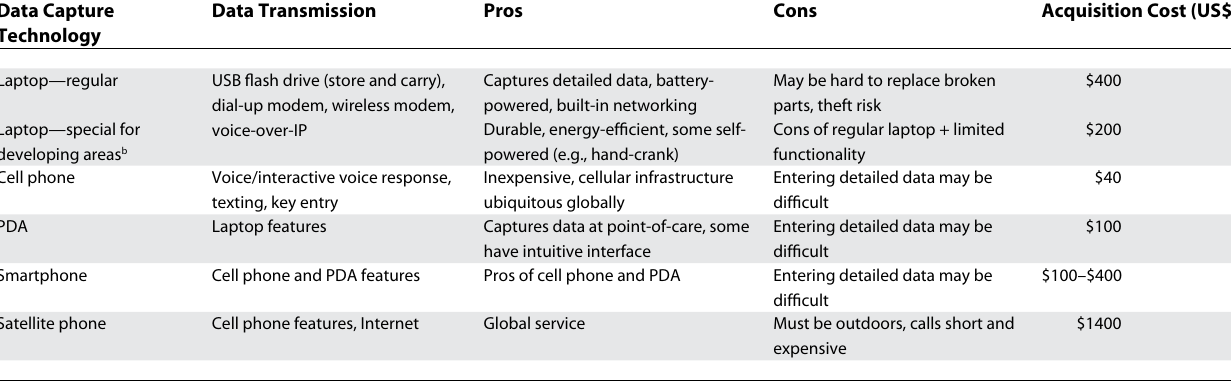
Table 1. Technology for Health Data Capture and Transmission in Remote Areas Data Capture